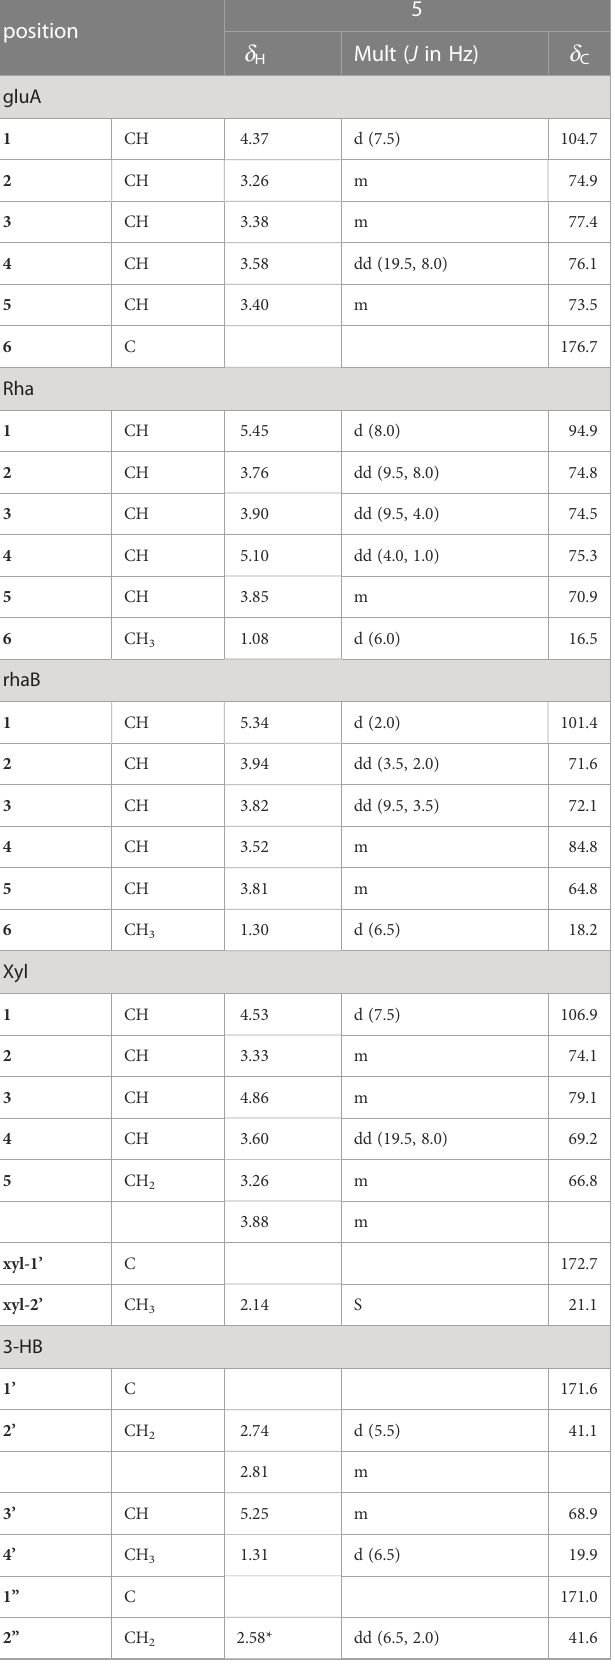
TABLE 3 1 H and 13 C NMR spectroscopic data of the sugar and 3-HB moieties of pannoside E (5).